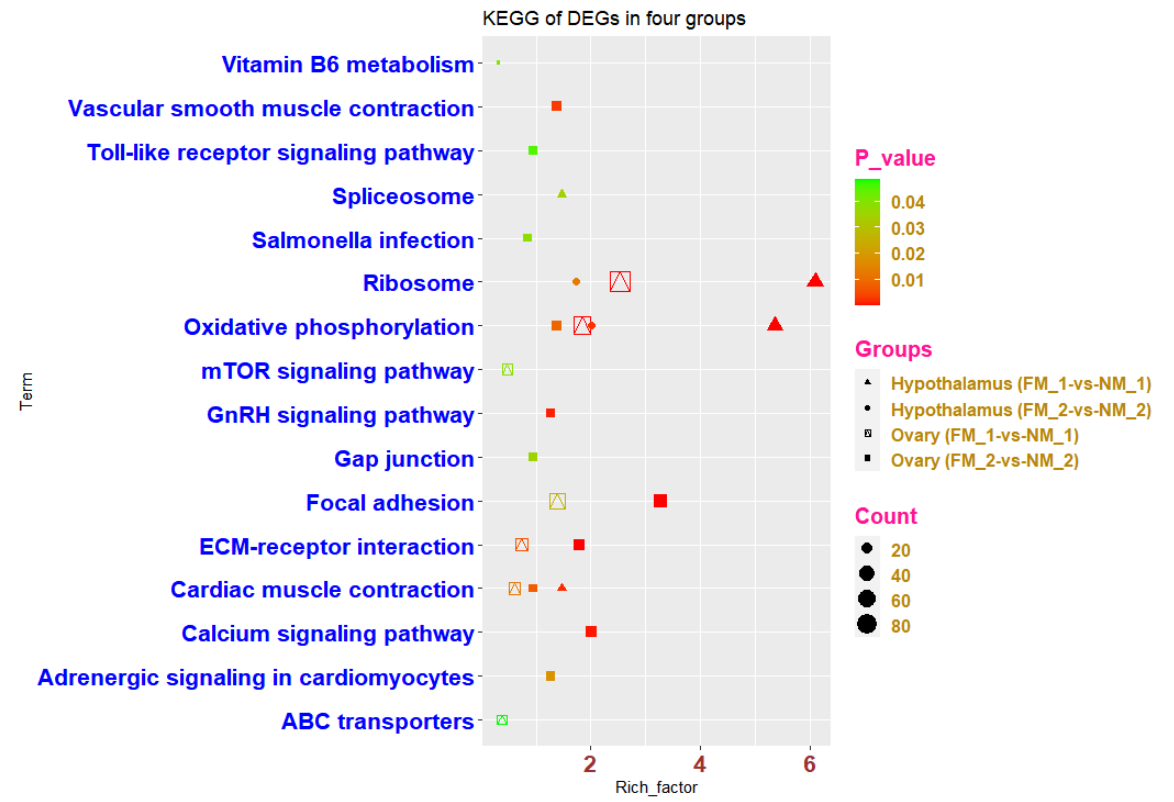
Figure 5. KEGG pathways for four groups of DEGs (hypothalamus and ovary in FM_1-vs-NM_1 and FM_2-vs-NM_2) in the same periods for different molting patterns.